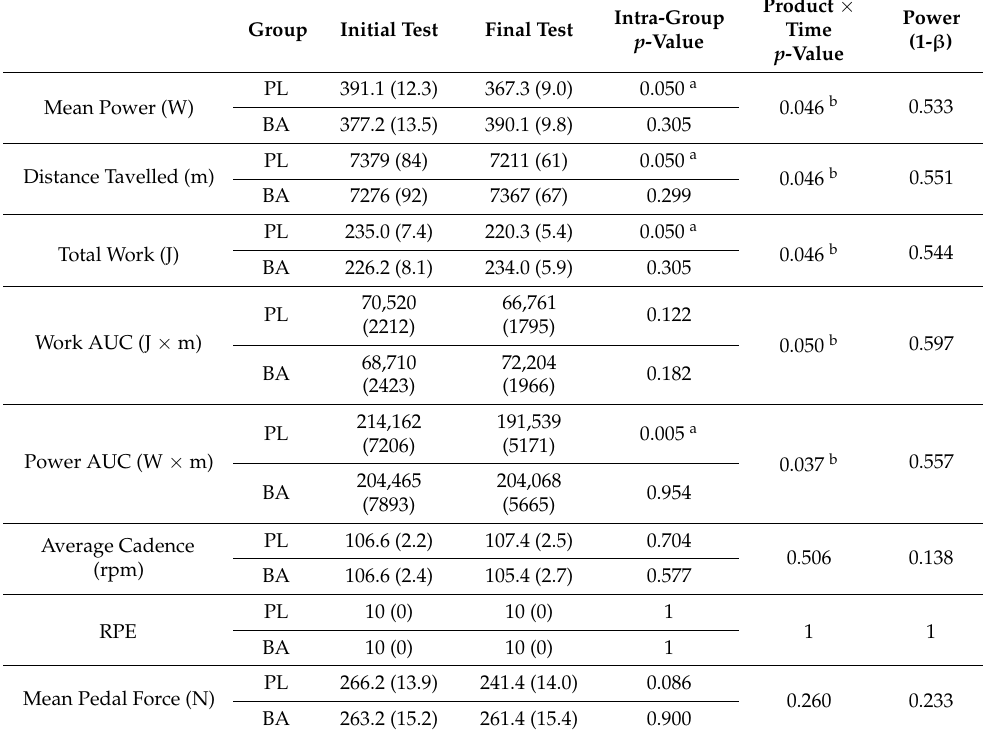
Table 2. Performance analysis of the 10 ′ TT. Values are presented as mean with standard error of the mean between brackets. AUC: Area under the curve (calculated by trapezoidal rule). rpm: rev- olutions per minute. RPE: rate of perceived exhertion.